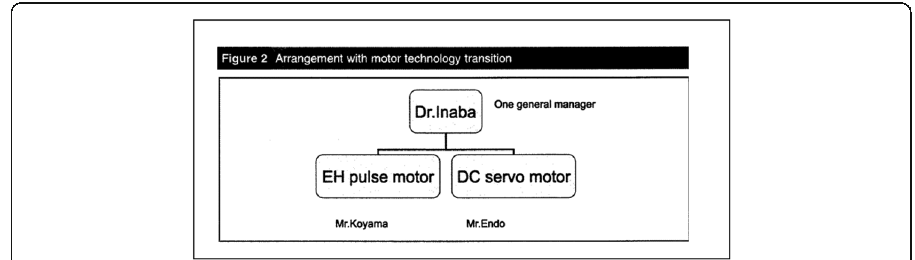
Fig. 4 Management arrangement for motor technology transition. Source: Shibata and Kodama T.